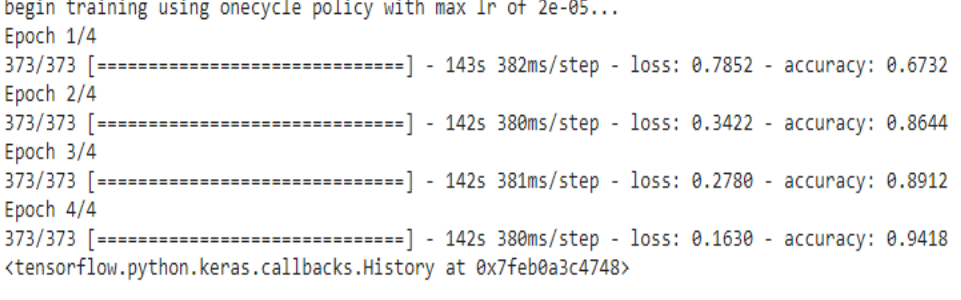
Figure 3. CovBERT model accuracy.